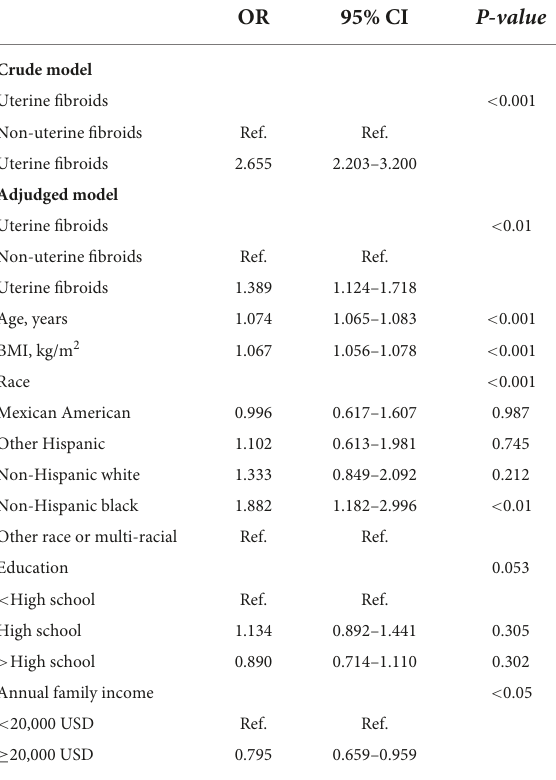
TABLE 3 Logistic regression analysis of uterine fibroids and cardiovascular diseases (CVDs) in diabetes individuals: National Health and Nutrition Examination Survey (NHANES) 1999–2006.